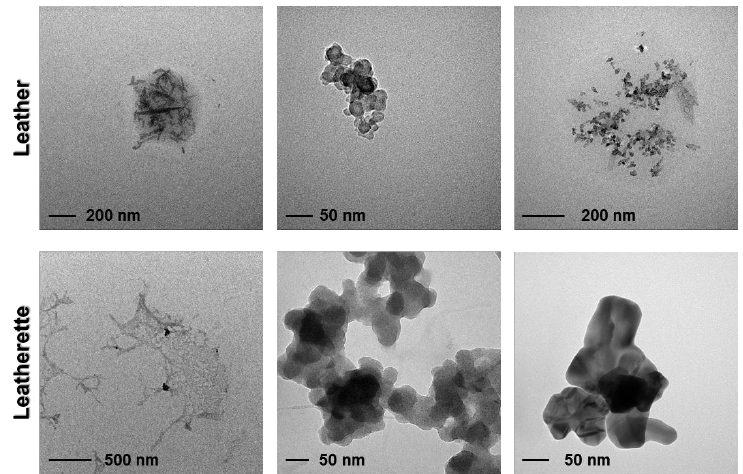
Figure 8. Transmission electron microscopy (TEM) micrographs of solutions in contact with treated leather (upper panels) and leatherette (lower panels). Most of the analyzed fields showed no inorganic particle at all. The few fields containing any measurable inorganic particle/aggregate are shown